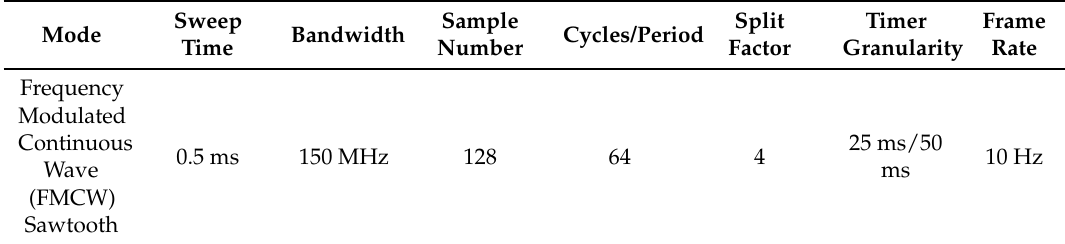
Table 5. Initial SDRADAR parameters for field